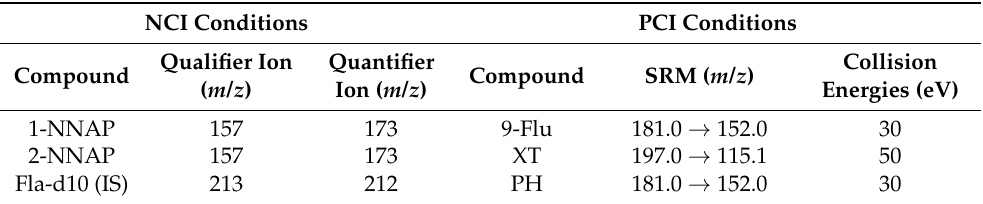
Table 1. Selected ions for the quantification of individual NPAH and OPAH congeners in NCI-SIM mode and transitions in PCI-SRM mode for MS detection.